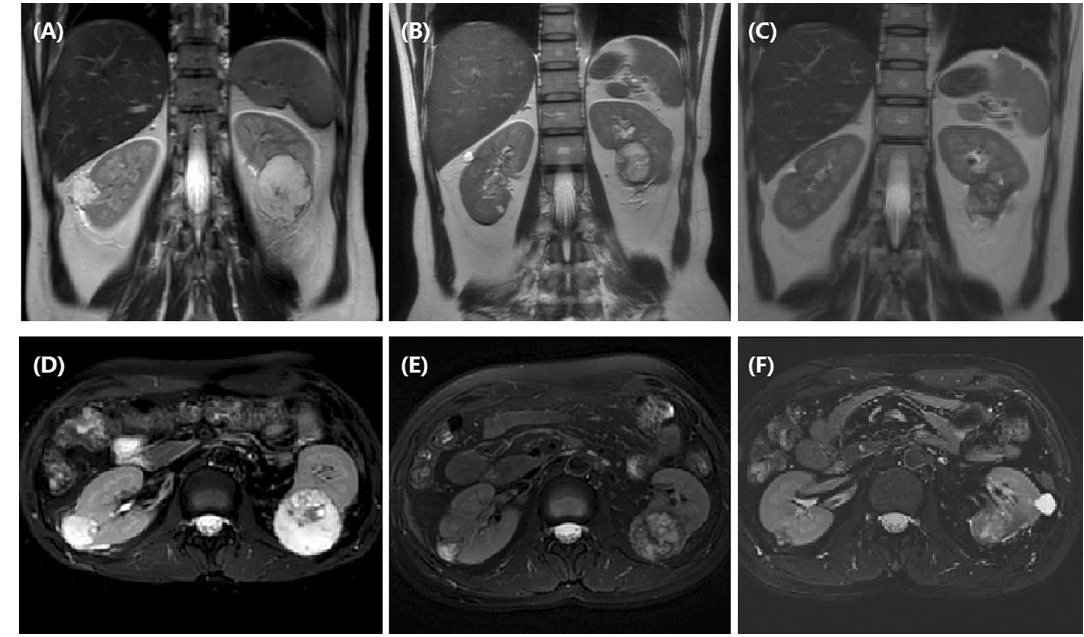
Figure 2. A 37-year female with bilateral RCCs followed up by MRI. ( A ) T2W-TSE series in coronal view showed bilateral RCCs before treatment. ( B ) Tumors shrunk significantly 1 month after DEB-TACE. ( C ) The right RCC almost disappeared after 3 months. T2-SPIR series in cross-sectional view showed the change of bilateral RCCs before ( D ), 1 month ( E ) and 3 months later ( F